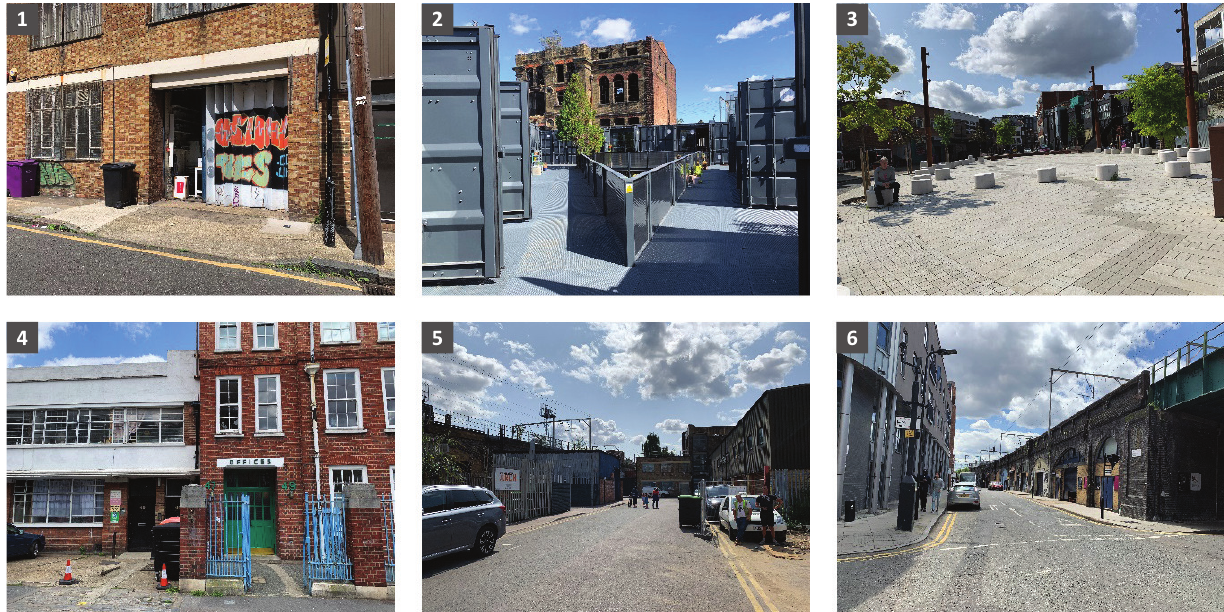
Figure 5. Present‐day photographs of Hackney Mare Street. Source: Photographs taken by the authors during weekday